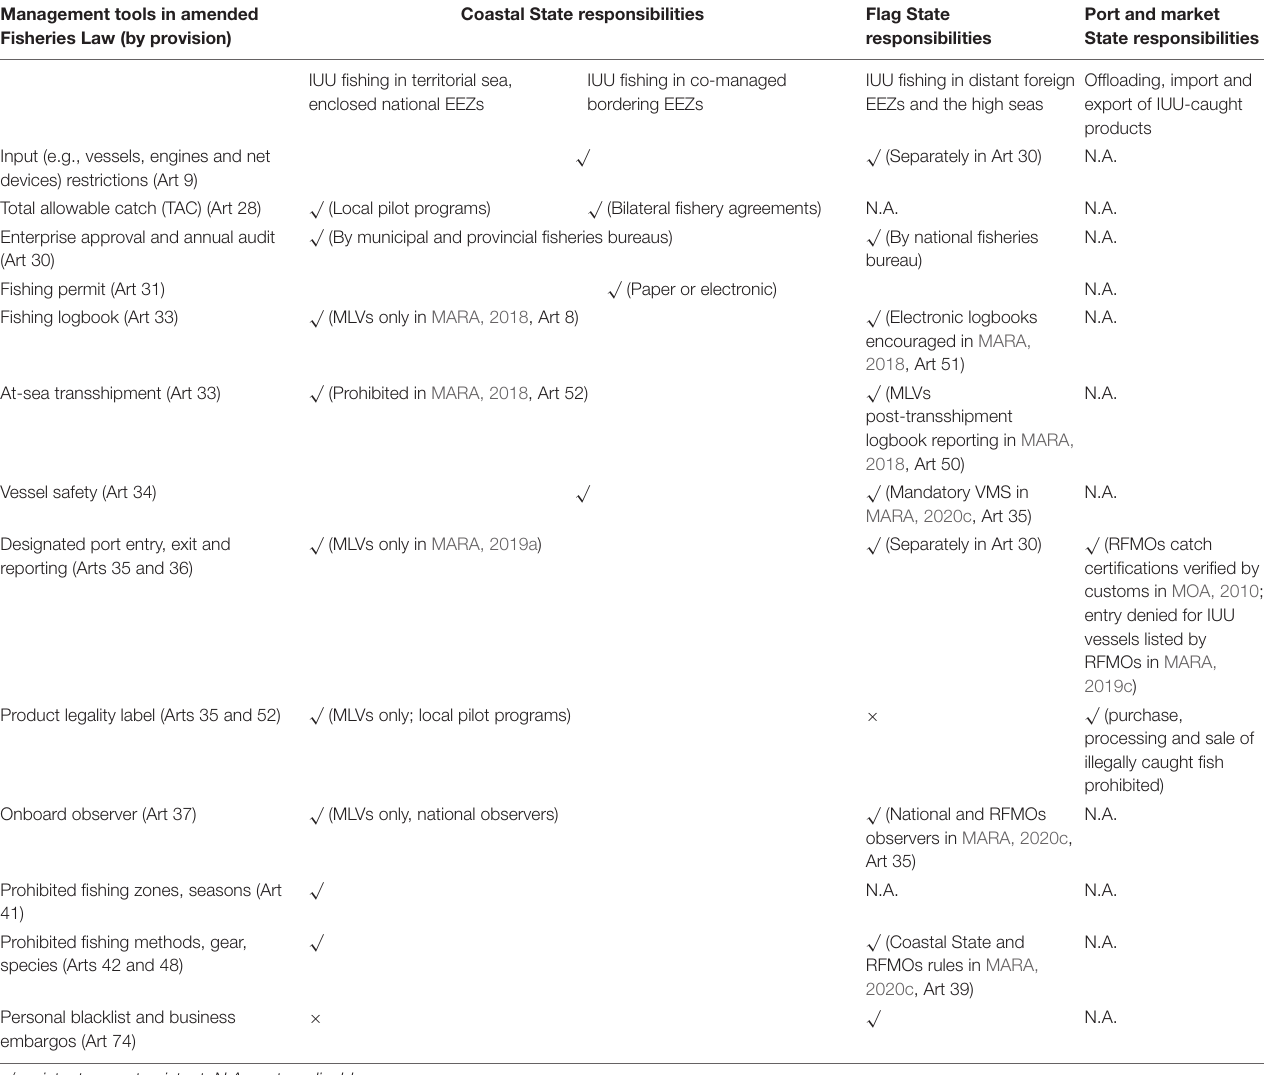
TABLE 1 | Amended Fisheries Law and sub-law provisions to address IUU fishing. Management tools in amended Fisheries Law (by